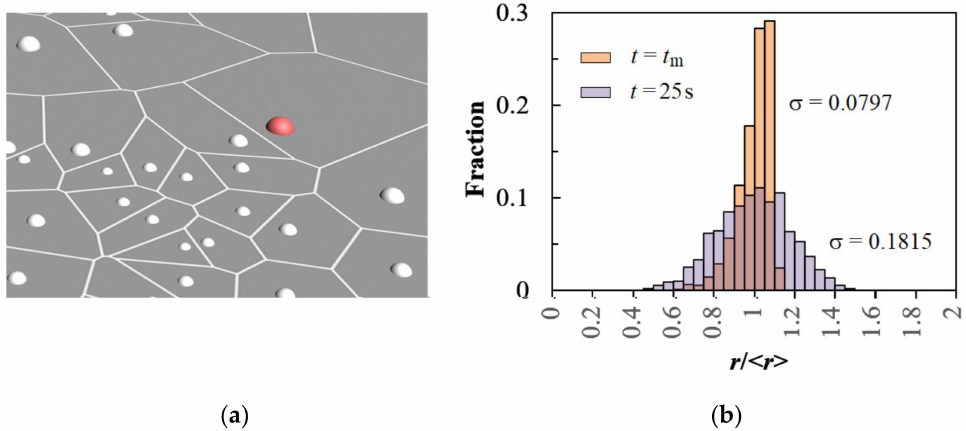
Figure 8. ( a ) Simulated 3D image of the electrode area with nuclei after diffusion-controlled growth of a random ensemble (see Figure 2a) for 25 s at η = 100 mV. The largest 48th nucleus is highlighted in red. ( b ) Nucleus radius distribution for the 1000 nuclei random ensemble. N 0 = 7.55 × 10 5 cm − 2 , t m = 0.875